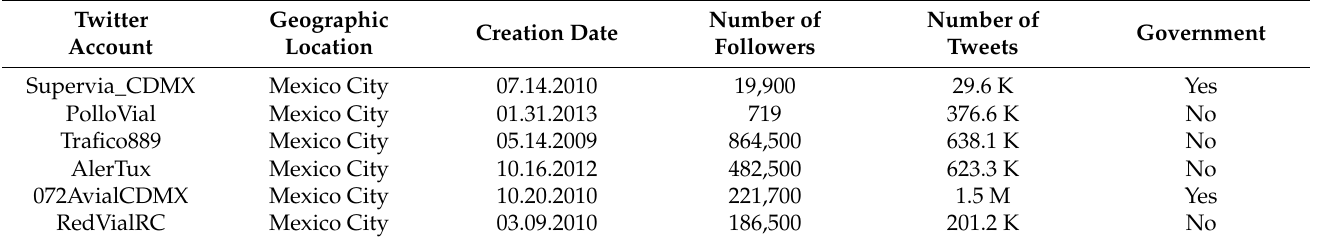
Table 5. Traffic-related Twitter accounts covering Mexico